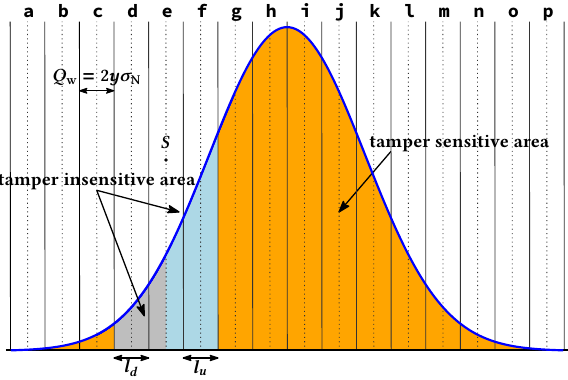
Figure 9: TS max of Profile 6. Please note the difference to Figure 6 where TS min node